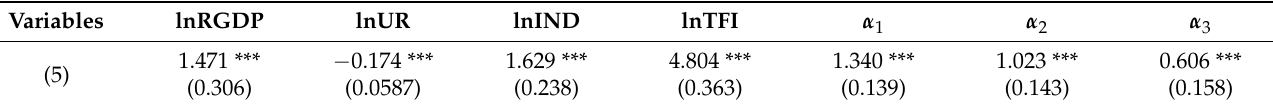
Table 6. Coefficient estimation results of the threshold